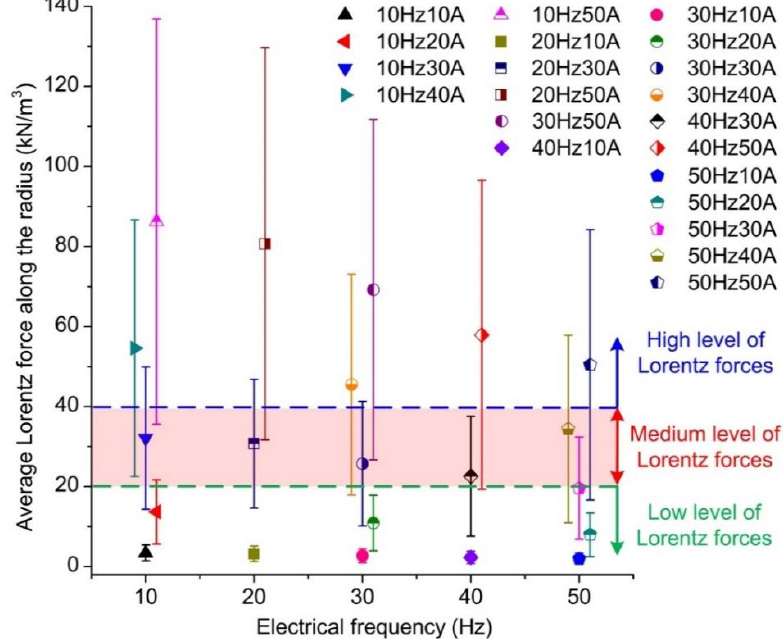
Figure 12. Summarisation of the average Lorentz force along the radius at different operating conditions.